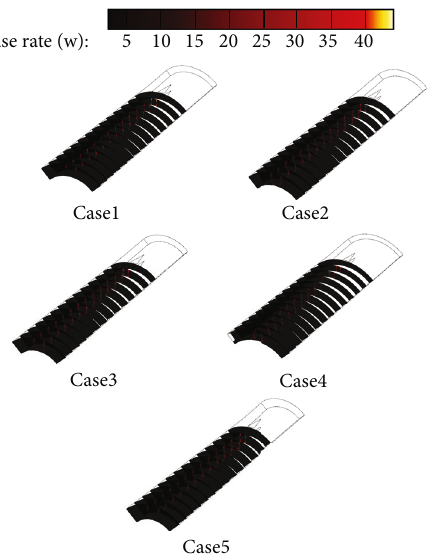
Figure 30: The heat release distribution for cases 1-5.